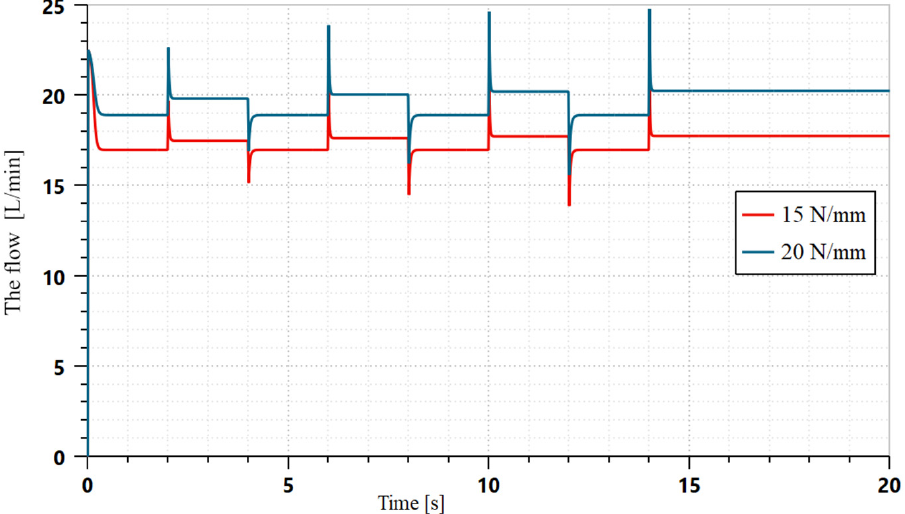
Figure 10. Flow rate changes when spring stiffness exceeded 12 N/mm.